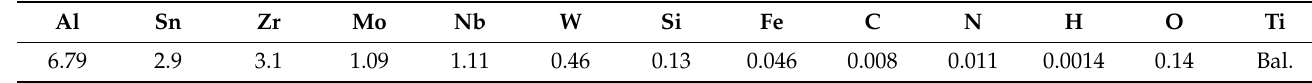
Table 1. Chemical composition (wt.%) of the alloy